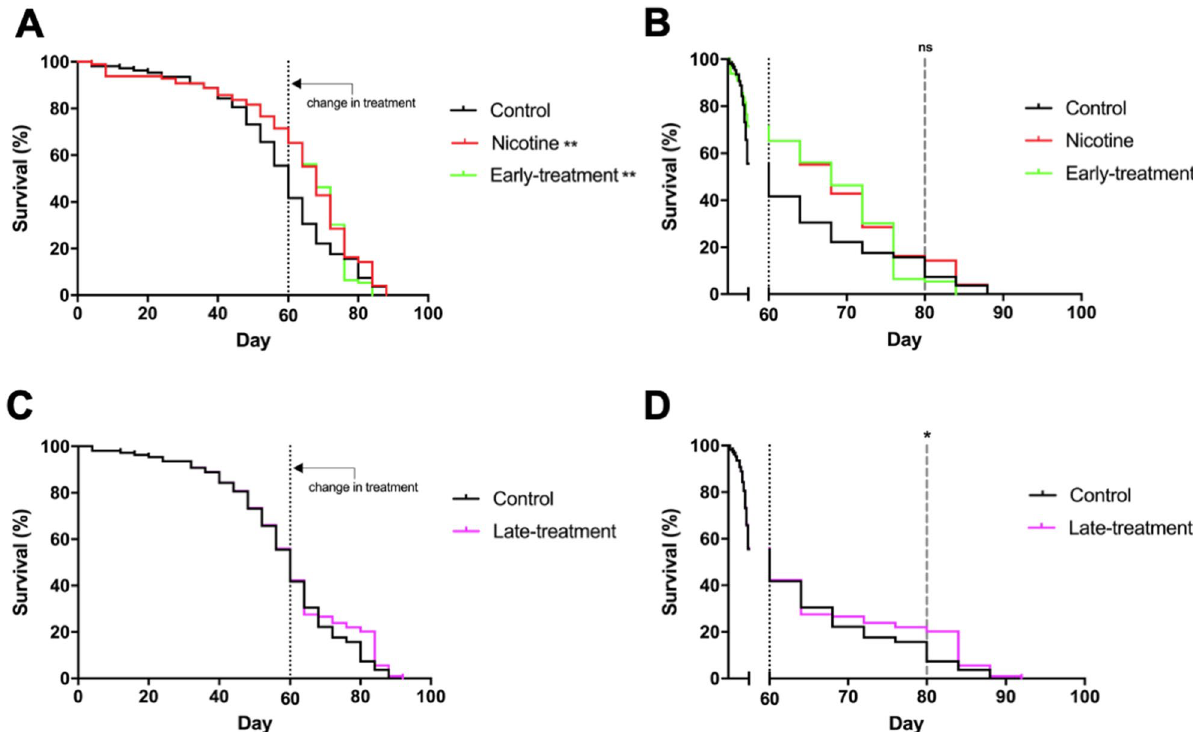
Figure 7. Late in life nicotine treatment increases survival in old flies that express Sph-1. Fifty percent of the population of flies expressing Sph-1 in dopaminergic neurons die by the time they are 60 days old. This time point was defined as the moment to shift treatment. ( A ) Flies that were treated for 60 days with nicotine (and were then transferred to normal food for the rest of their lives), had a significantly longer lifespan compared with untreated animals; a slight reduction in the lifespan of these flies can be observed when compared with animals that were chronically treated with nicotine for their whole life (80 days), however, this reduction was not statistically significant between these two groups. ( B ) Zoom in of the data shown in panel ( A ) after the 60 day time point to better observe the late lifetime effects. ( C ) Animals not treated with nicotine until they are 60 days old and onwards exhibit a significant increase in their lifespan compared with untreated ones. ( D ) Zoom in of the data shown in panel ( C ) the 60 day time point. Statistical analyses were performed using Log-rank